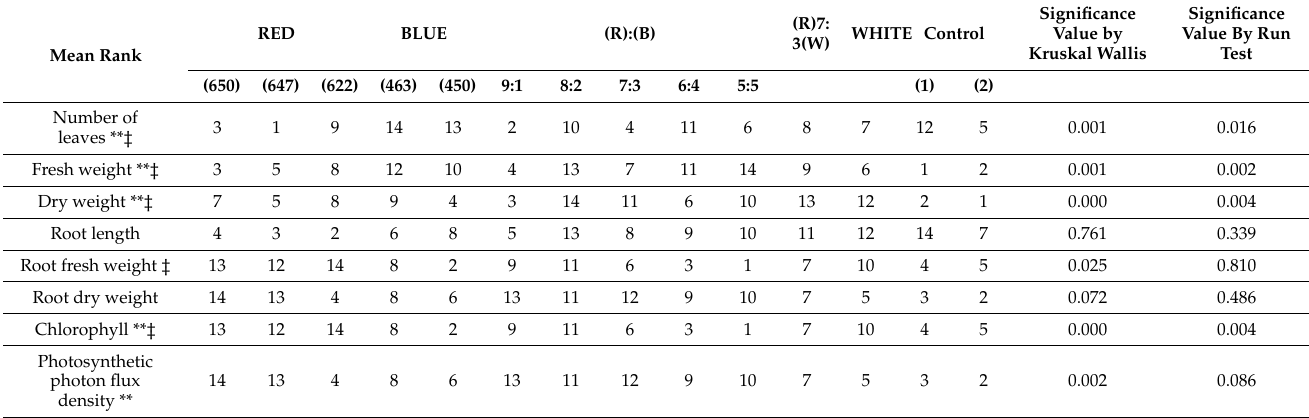
Table 3. Ranks in the plant factory obtained by Kruskal–Wallis test and significance by Run